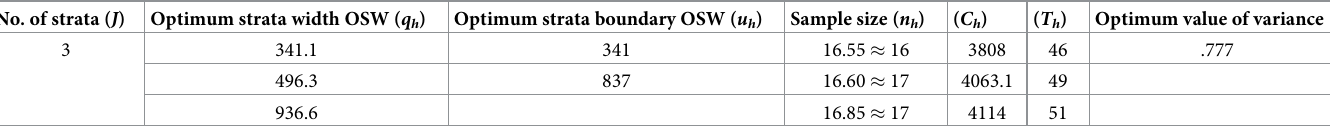
Table 1. Results for OSB, optimum sample size of the variance function for exponential distribution when J = 3. No. of strata ( J ) Optimum strata width OSW ( q h )